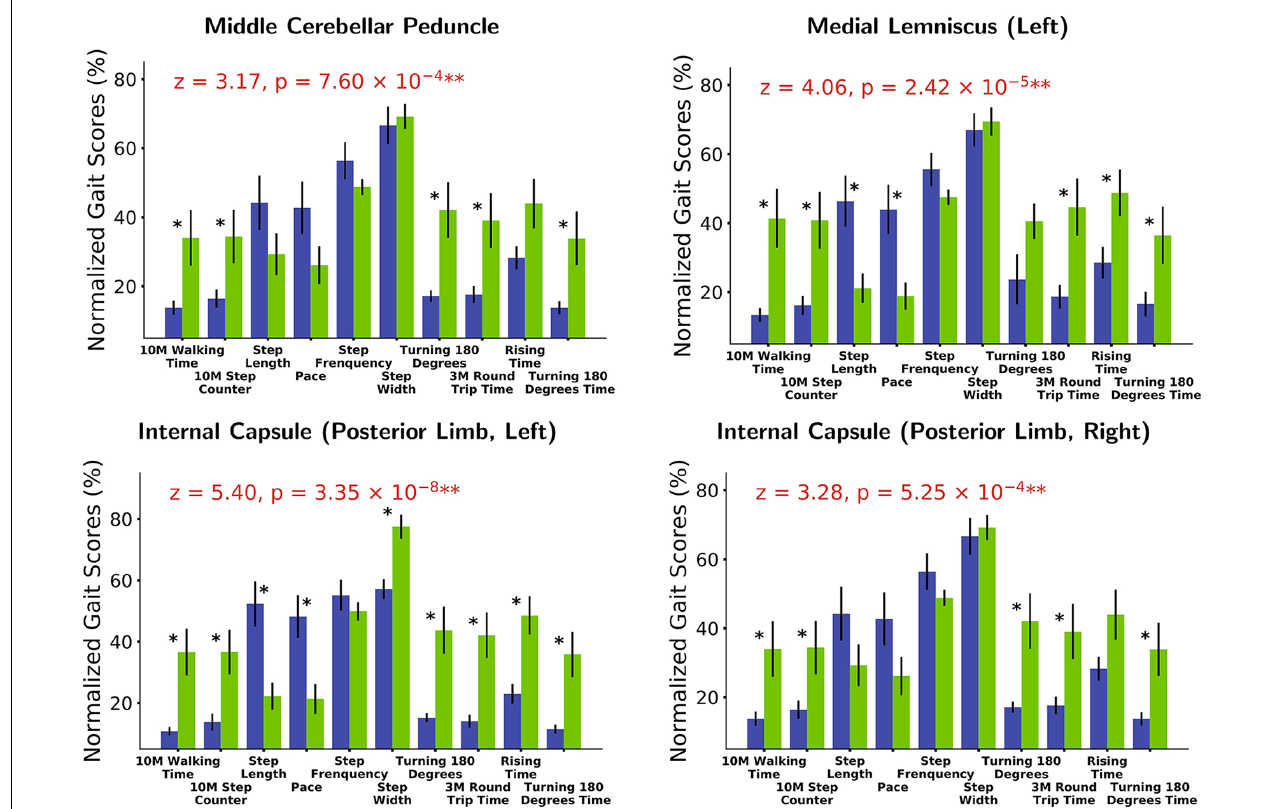
FIGURE 3 | White matter tracts with strongest gait index relationships. Based on white matter hyperintensities (WMH) extracted from different white matter tracts, patients are separated into two groups (blue in the graph: patients with fewer WMHs. Green: those with more WMHs). Various gait score (normalized based on maximum values) differences are observed between the two groups. Gait score differences are combined (Fisher’s method) to extract white matter tracts most strongly related with gait indices [middle cerebellar peduncle (MCP): z = 3.17, p = 7.60 × 10 − 4 and medial lemniscus (left): z = 4.06, p = 2.42 × 10 − 5 ; internal capsule (IC; posterior limb, left): z = 5.40, p = 3.35 × 10 − 8 and internal capsule (posterior limb, right): z = 3.28, p = 5.25 × 10 − 4 ]. * p < 0.1, ** p <